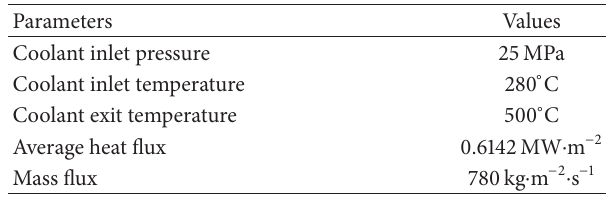
Table 2: Reactor operation parameters and correlations options in current analysis.